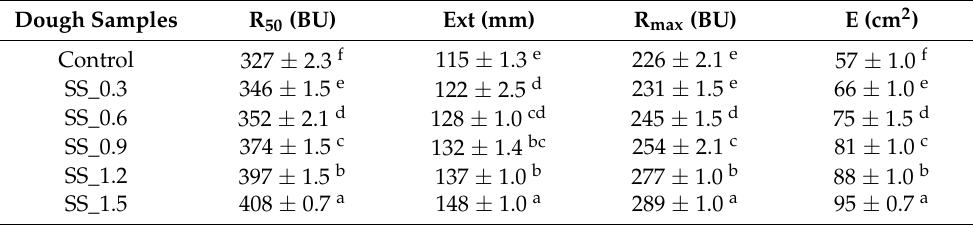
Table 2. Extensograph parameters at the proving time of 135 min of the dough samples with different levels of sea salt with low sodium content (SS)